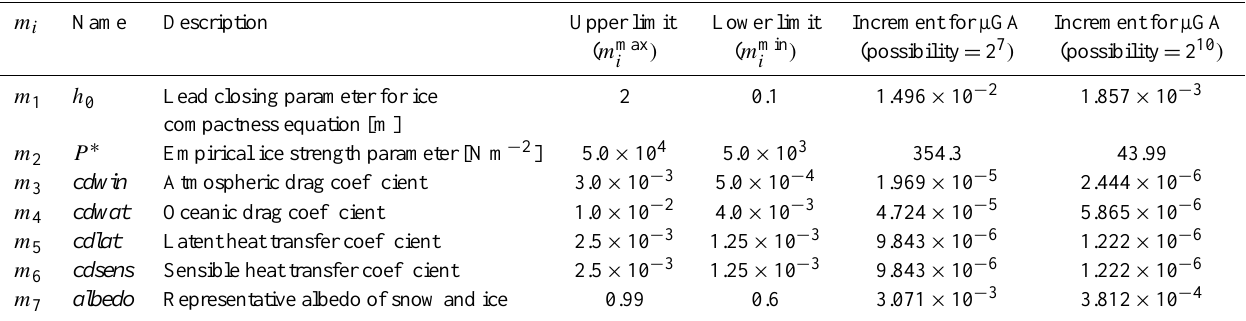
Table 2. Parameters applied for the optimizations. The representative albedo of snow and ice is related to respective albedo values in the manner described in the